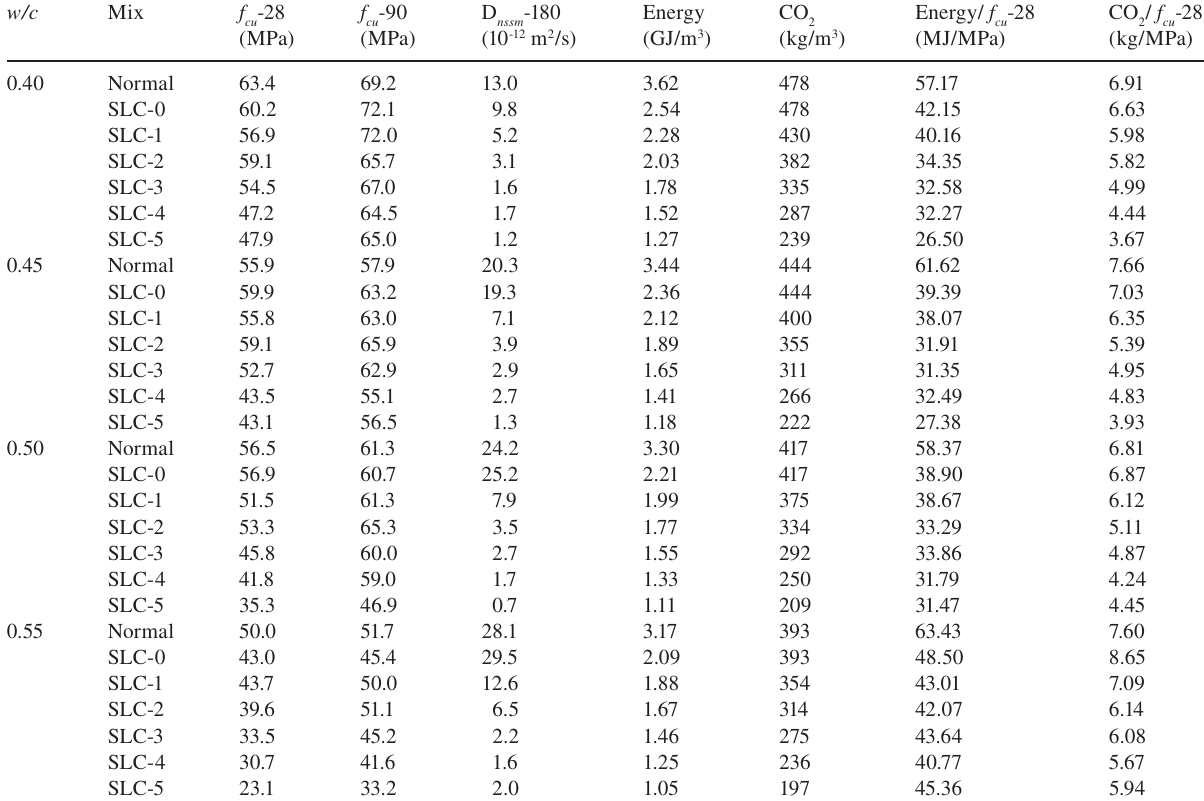
Table 4 Material sustainability indicators (MSIs) of “ sandless ” concrete.